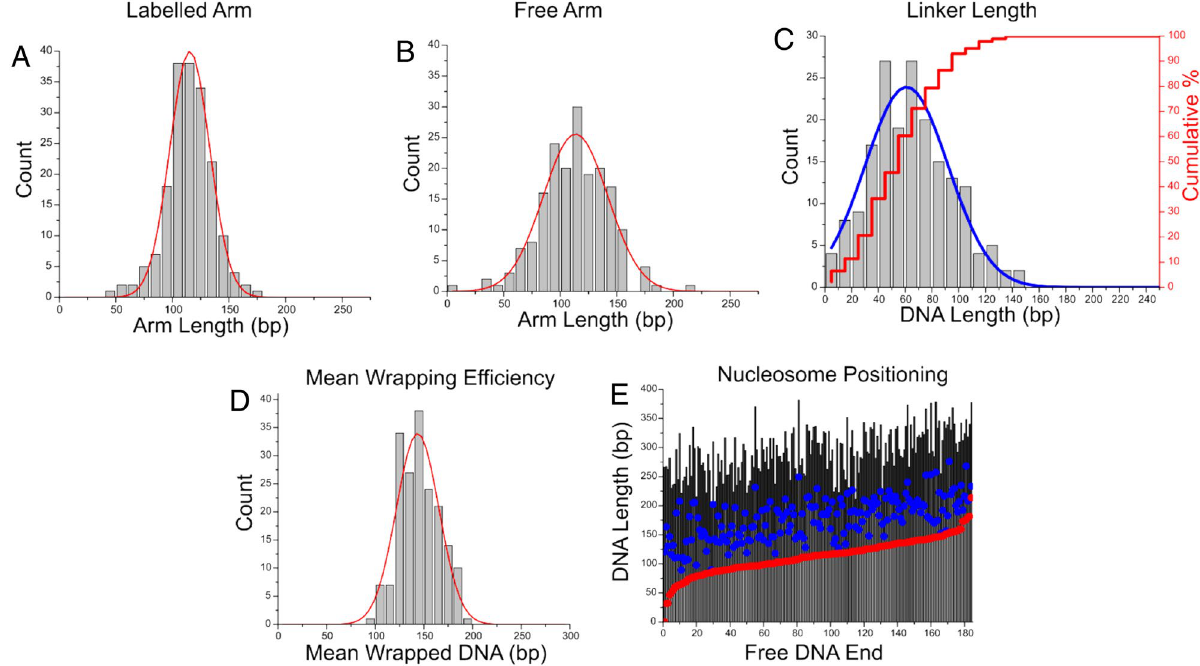
Figure 6. Analysis of modified dinucleosomes with the H4 histone tail truncated assembled on the dinucleosome substrate with two positioning motifs. Histograms ( A , B ) reveal mean labelled and free arm lengths of 115 ± 2 bp (SEM) and 113 ± 2 bp (SEM), respectively, which correlate to the position of the 601 motifs. ( C ) Histogram of the linker length between two nucleosomes. The mean linker length value is 65 ± 2 bp (SEM), which is slightly higher and broader than observed for canonical nucleosomes on the same substrate. Histogram ( D ) reveals a mean value of 145 ± 1 bp (SEM). ( E ) Positional mapping of modified dinucleosomes demonstrates a weaker preferential positioning for both nucleosomes when compared with canonical dinucleosomes assembled on the same